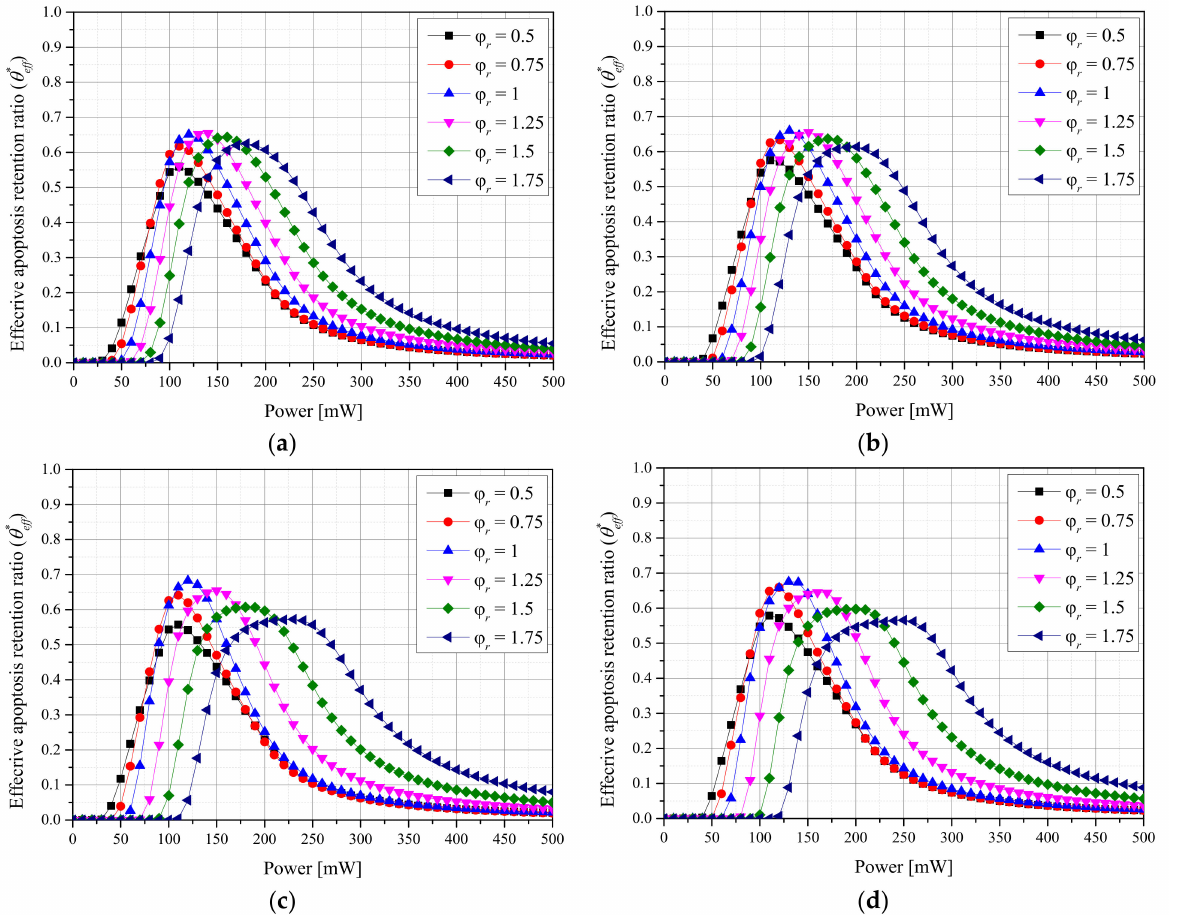
Figure 5. ( a ) Gaussian profile, f v = 10 − 3 . ( b ) Gaussian profile, f v = 10 − 6 . ( c ) Top-hat profile, f v = 10 − 3 . ( d ) Top-hat profile, f v = 10 − 6 . Effective apoptosis retention ratio ( θ ∗